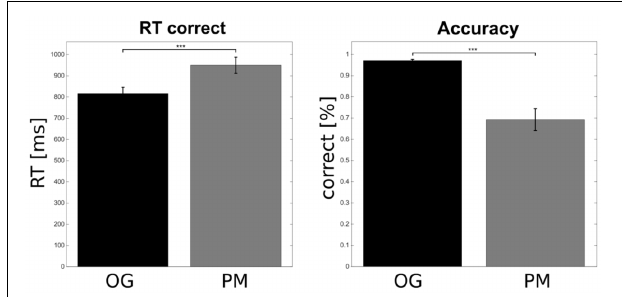
FIGURE 2 | Behavioral results. Participants responded faster to the OG compared to the prospective memory (PM) trials. The accuracy on the OG trials was higher compared to the PM trials. Error bars show the standard error of the mean ( ∗∗∗ p <